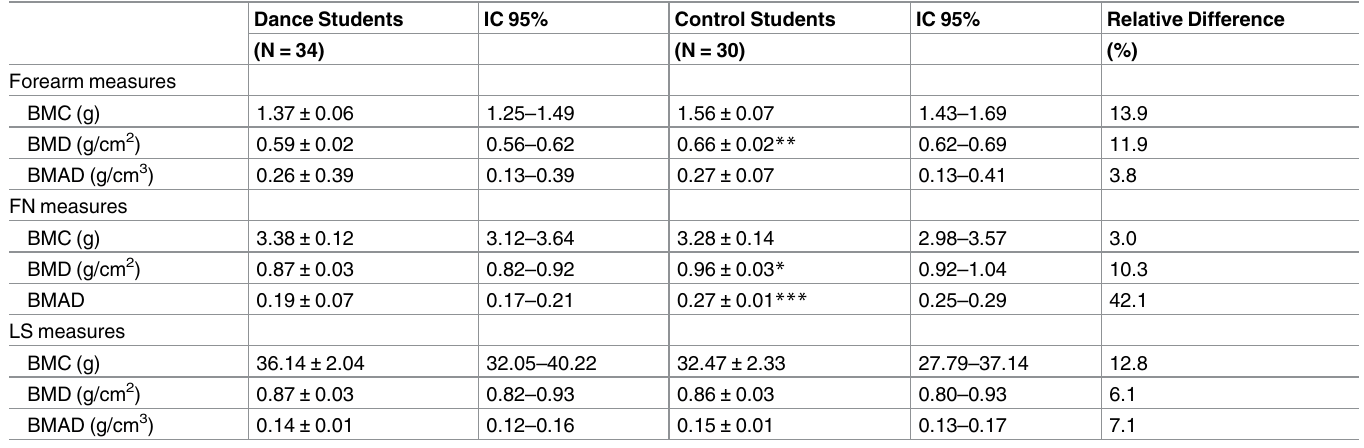
Table 4. Adjusted bone parameters for Tanner stage, height, body weight and calcium